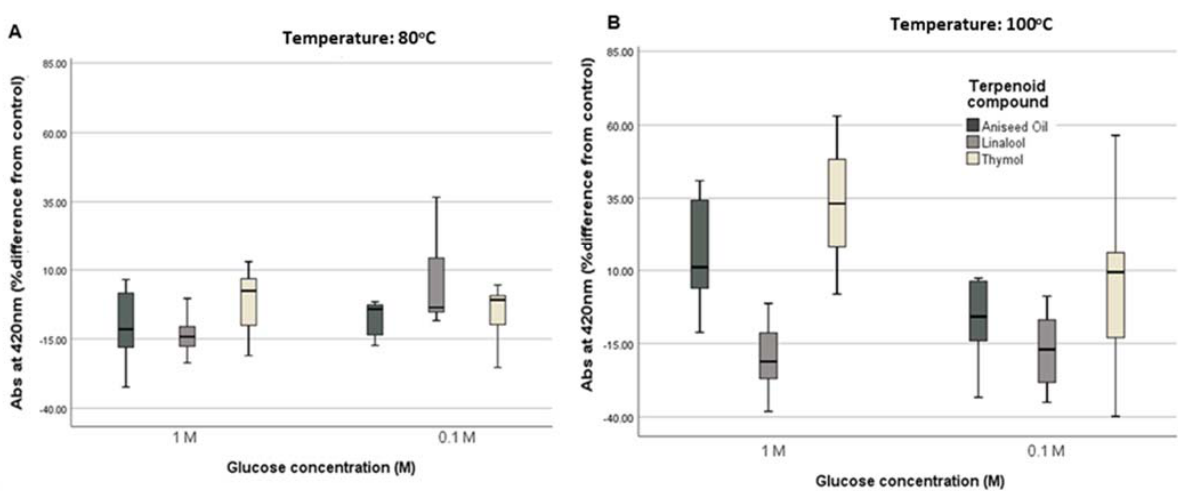
Figure 6. The effect of terpenoid compounds on advanced glycation products formation (420 nm) in heated glucose/lysine solutions at 0.1 M and 1 M glucose at pH 7.2 and ( A ) 80 °C and ( B ) 100 °C. Symbols outside the boxplots indicate outliers.